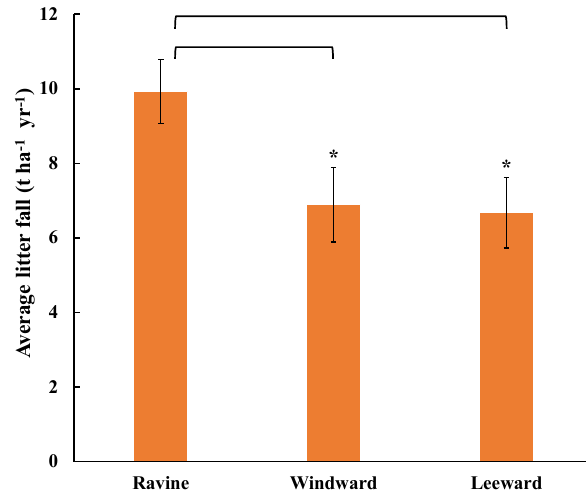
Figure 1. Annual litterfall in three habitats of Nanjenshan Reserve. Annual productivity of litterfall in ravine habitat was higher than windward and leeward habitats (* p